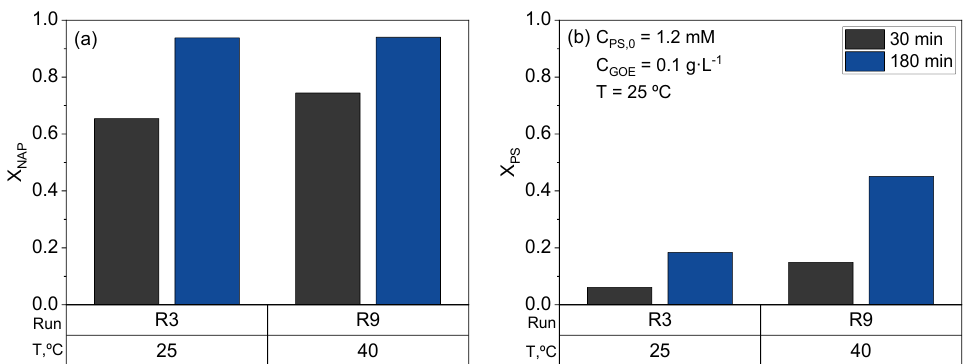
Figure 3. Effect of temperature in ( a ) conversion of NAP; ( b ) conversion of PS at 30 min and 180 min. 𝐶 NAP,0 = 0.1 mM,𝐶 PS,0 = 1.2 mM,𝐼 = 0.18 W · cm −2 and 𝐶 GOE = 0.1 g · L −1 .